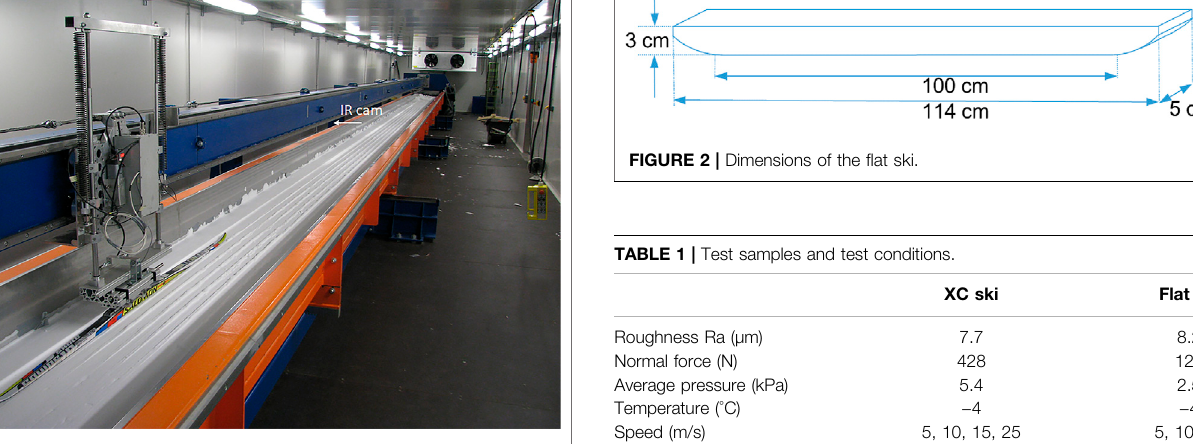
FIGURE 1 | Snow Tribometer with position of IR cam. The camera is mounted below the horizontal beam and is tilted by 15 ° from the vertical.